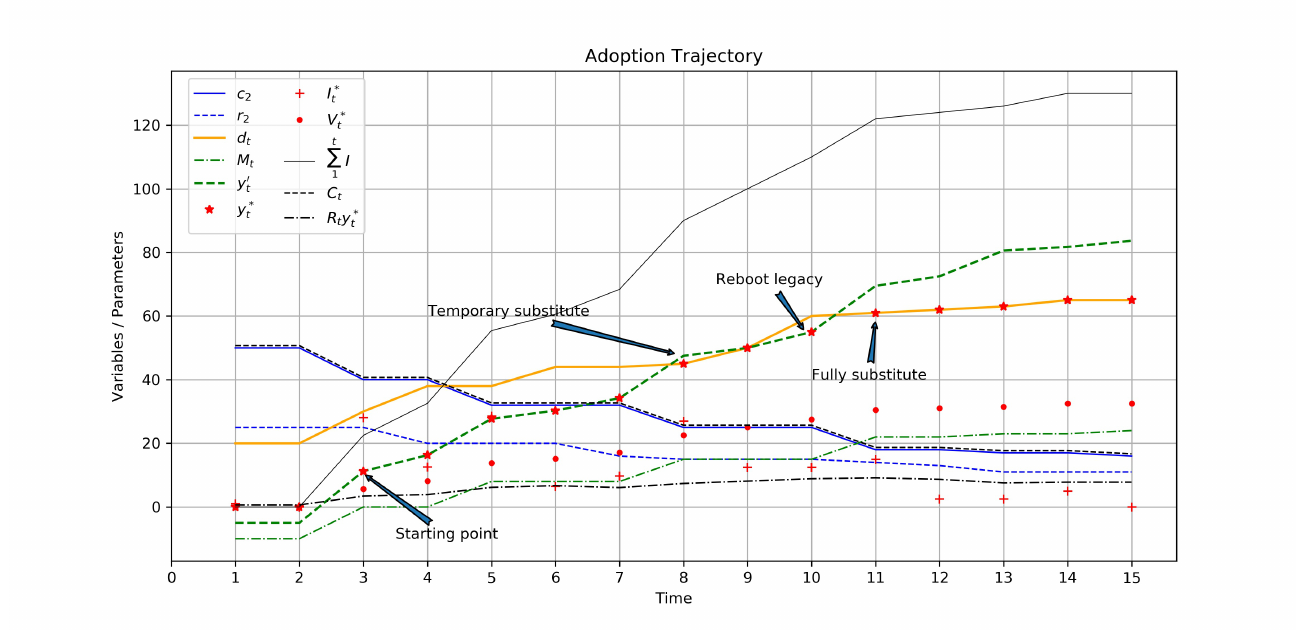
Figure 5. Adoption